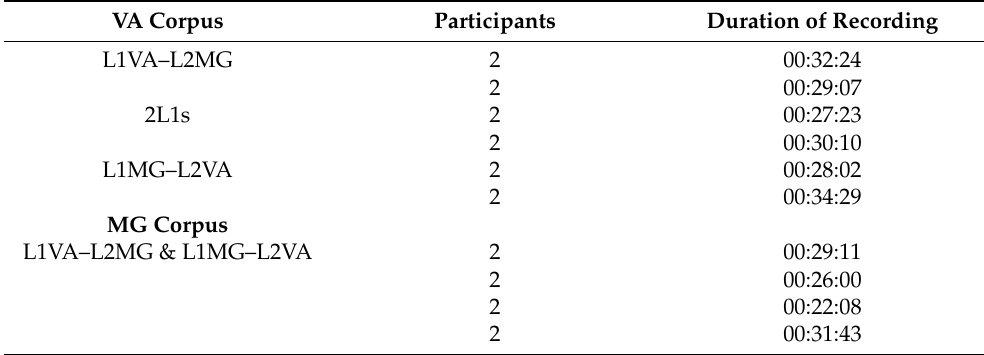
Table 5. The oral